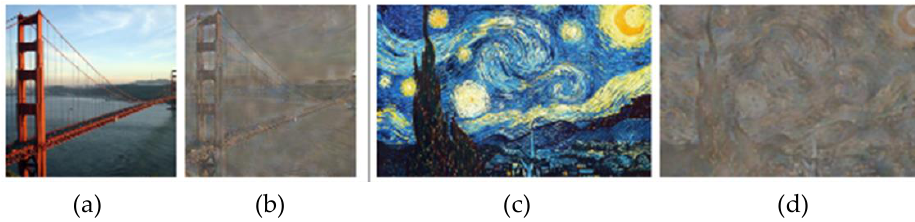
Figure 5. Results of directly decoding the whitened features: ( a , c ) are content images, and ( b , d ) are reconstruction results after whitening transform.